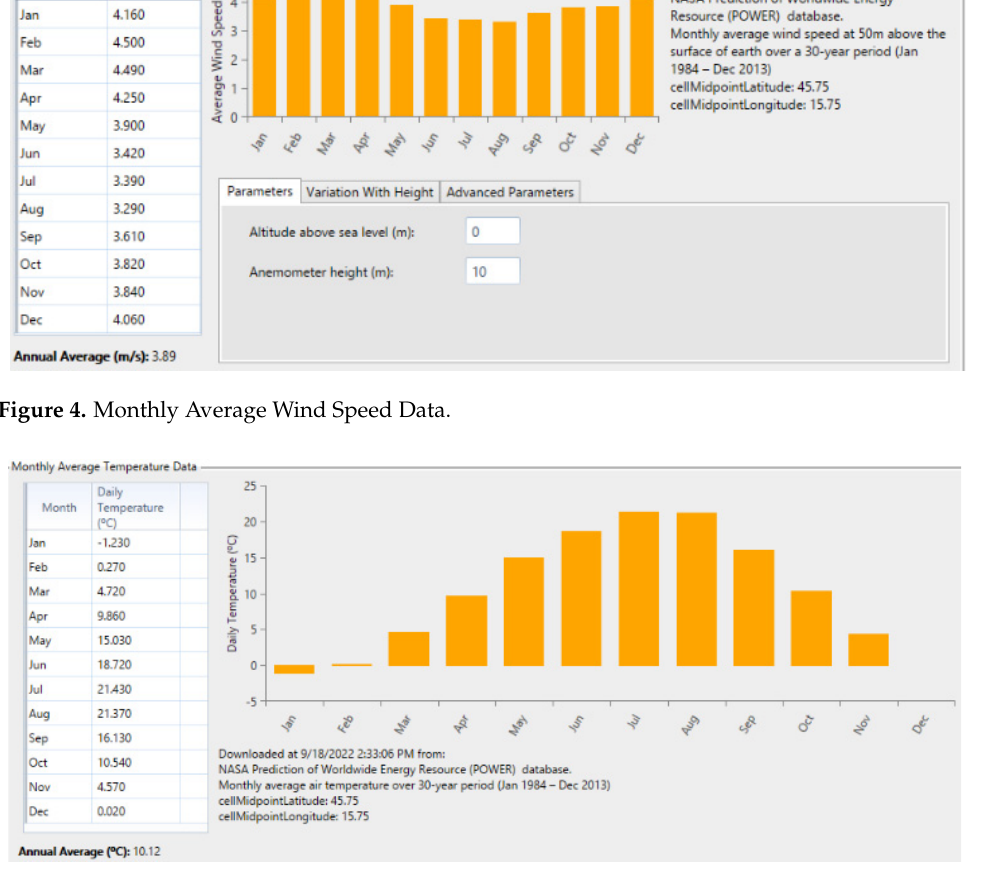
Figure 5. Monthly Average Temperature Data for selected location.